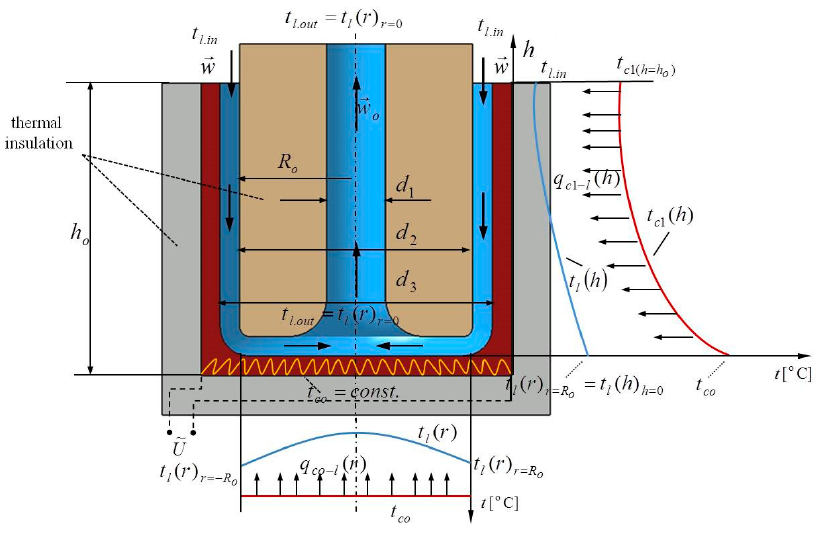
Figure 3. The peripheral impinging liquid jet on the bottom of the cylindrical cavity.